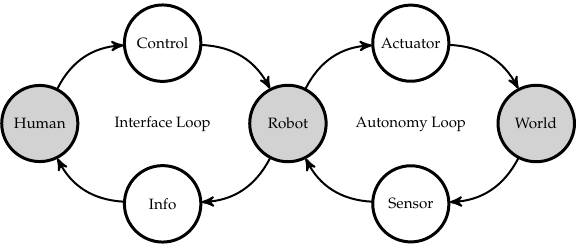
Figure 2. Remote robot operation (adapted from Crandall et al.